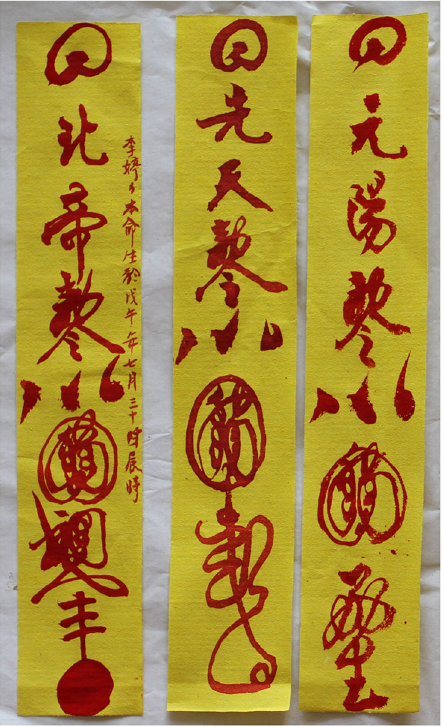
Fig. 1 Talismans produced by a Daoist in Le ’ an county 樂 安 縣 in north- central Hunan, 2010. Photo by David Mozina with permission to